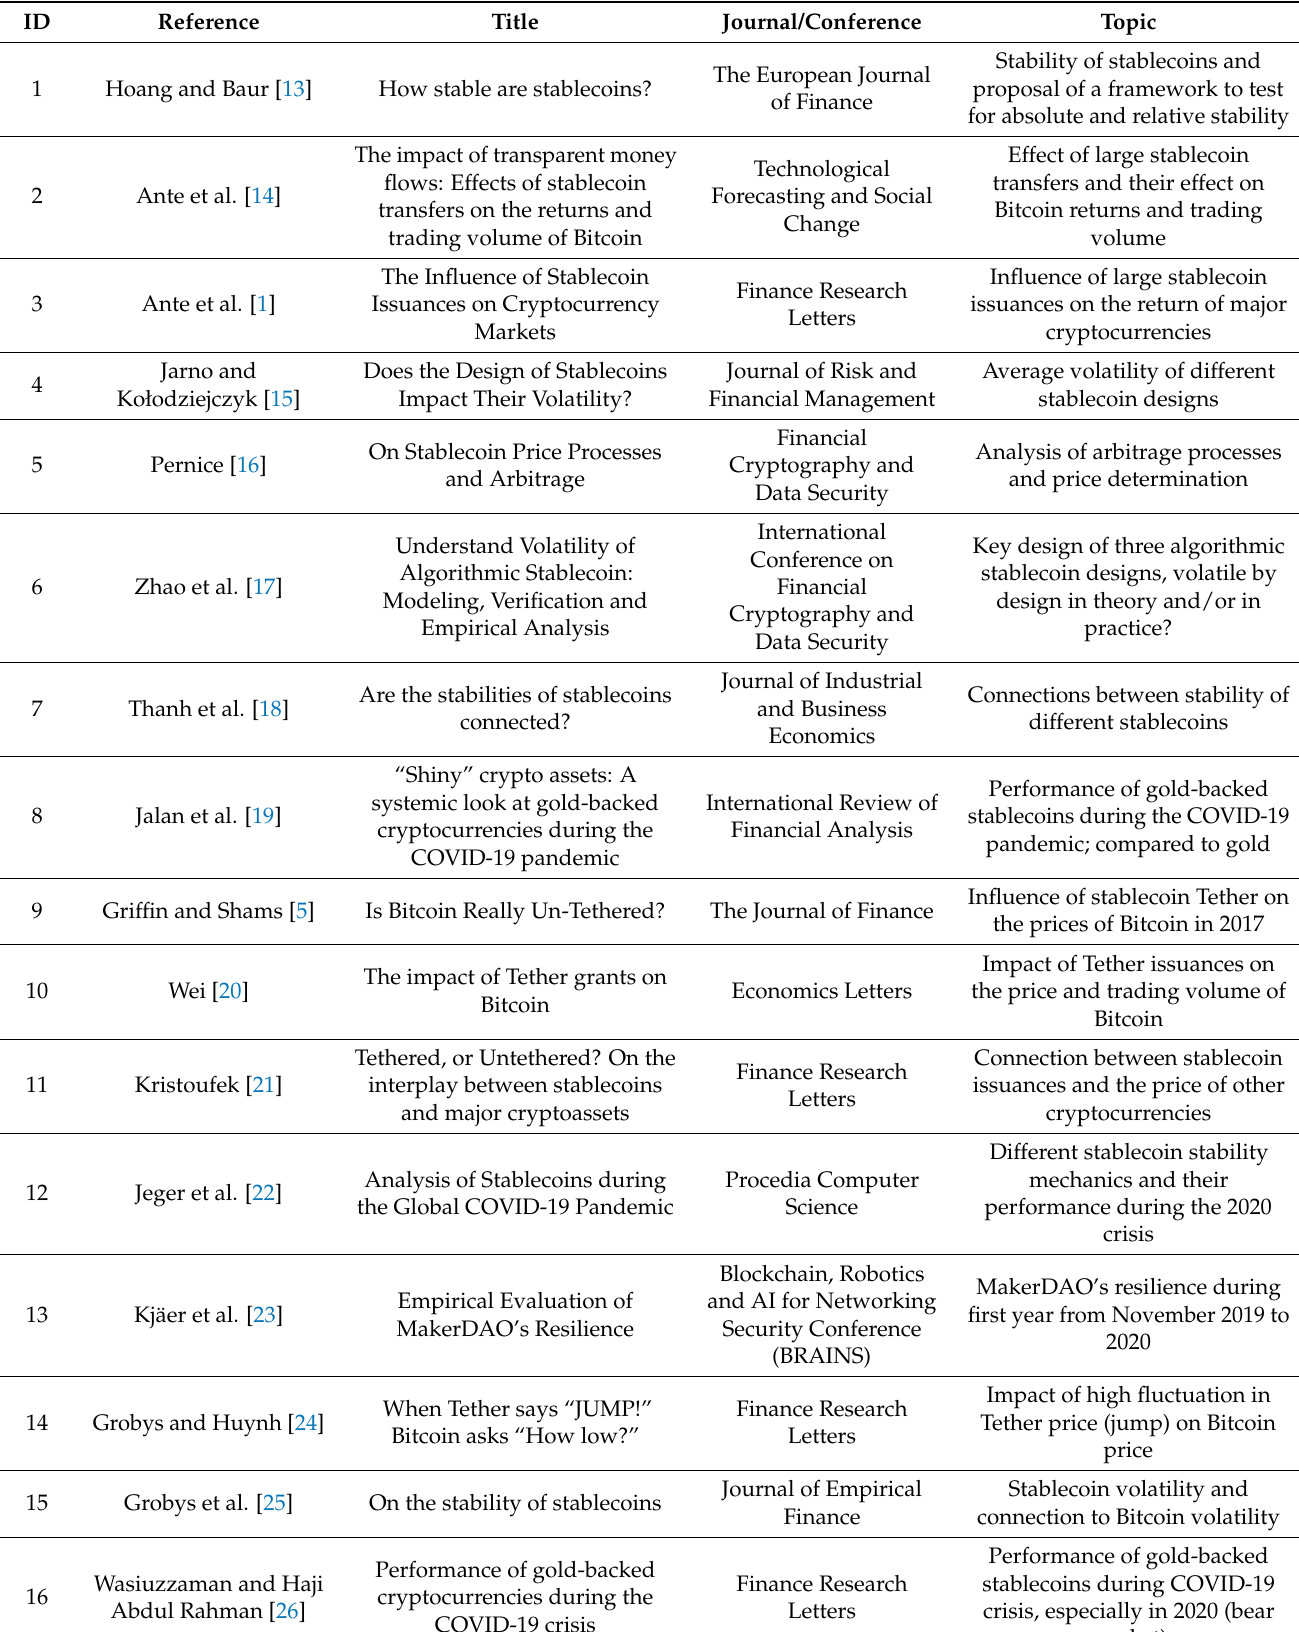
Table 1. Identified